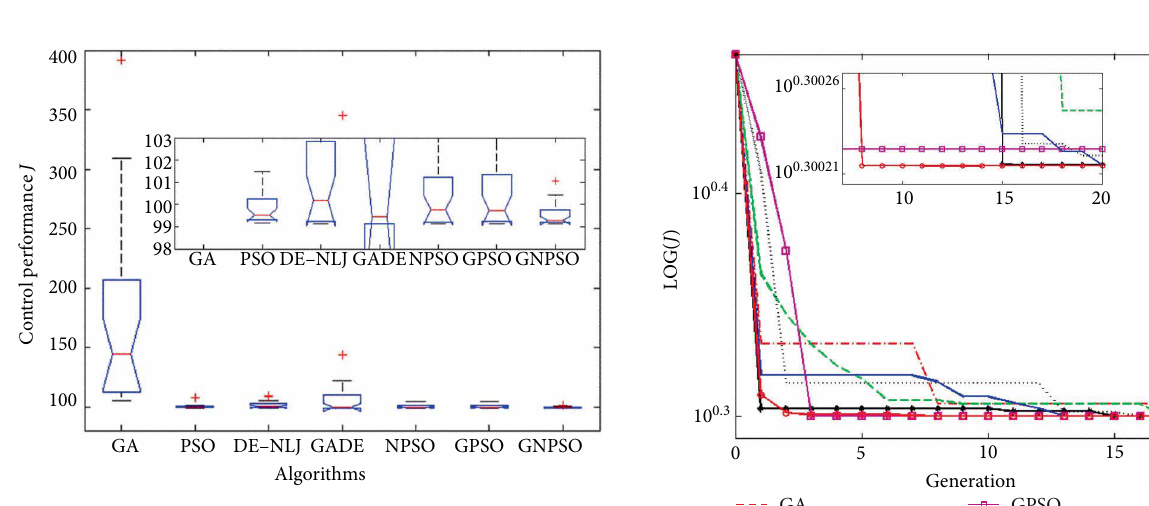
obtained by 𝐹 𝑚𝑖𝑛